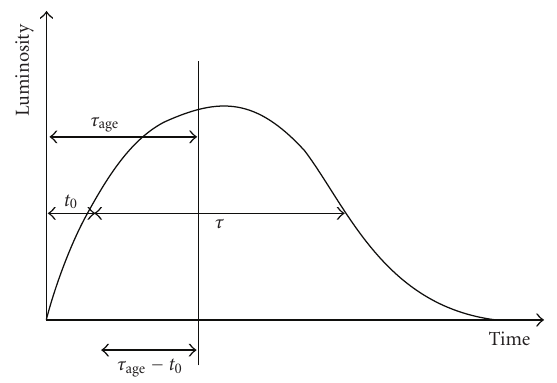
Figure 1: The di ff erent variables used in this calculation. t 0 is defined as the time when the luminosity is above a certain threshold value which makes the object detectable; τ is defined as the time period where the transient can be detected, and τ age is an arbitrary age since explosion, with τ age − t 0 being the time period where events younger than τ age can be detected.